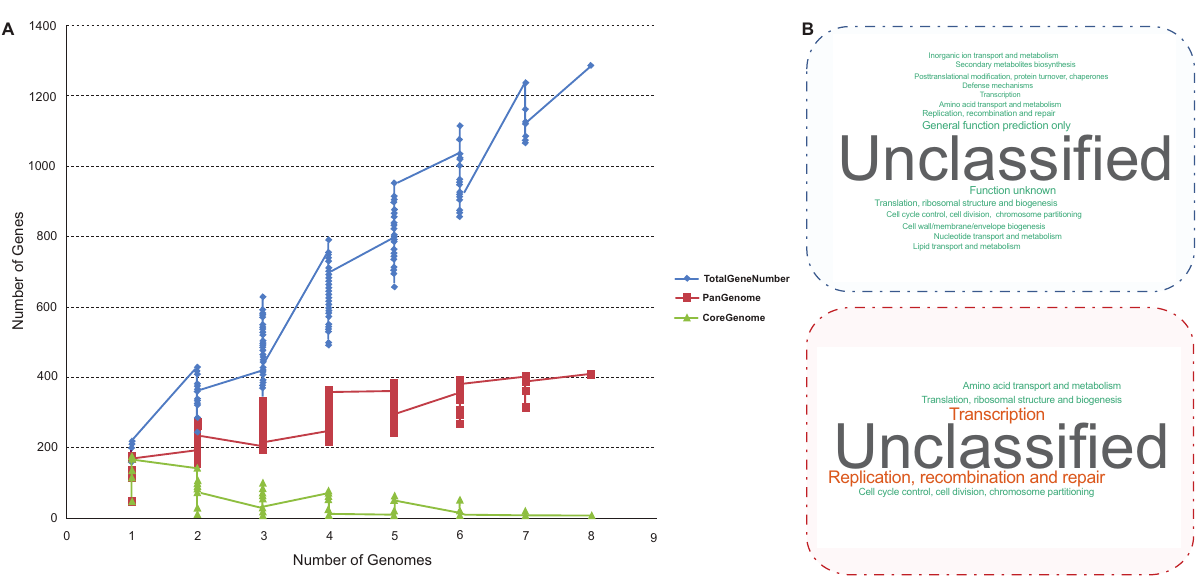
Figure 2. ( A ) Pangenome plot of the SI region considering seven V. cholerae and one V. mimicus genomes. 1285 total genes, 408 pangenome clusters and eight core clusters were identified. ( B ) Word clouds of cluster function enrichment comparison according to clusters of orthologous groups (COG) for whole and core clusters identified are shown at the top and bottom, respectively. Clusters that are not assigned in the COG classification were excluded from the figure. distributed or dispensable genes and 204 are unique genes.